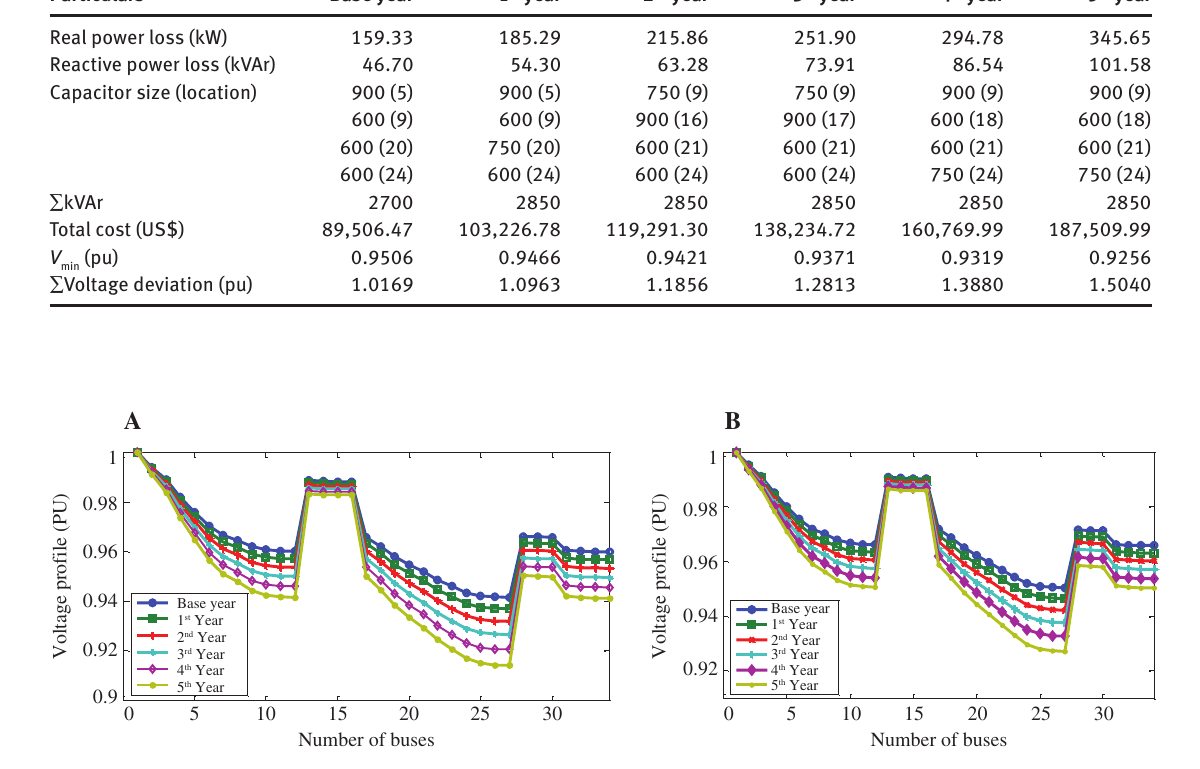
Table 11: Year-wise Analysis on the 34-Bus Distribution System after OSCsP Using the GABC Algorithm. Particulars